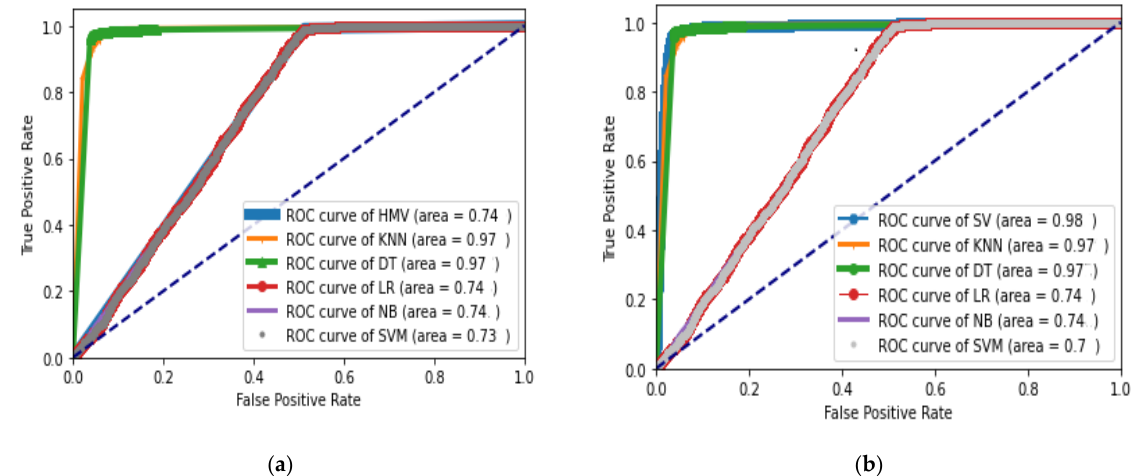
Figure 5. ROC curve Showing performance of ( a ) Majority Voting Hard and ( b ) Majority Voting Soft.